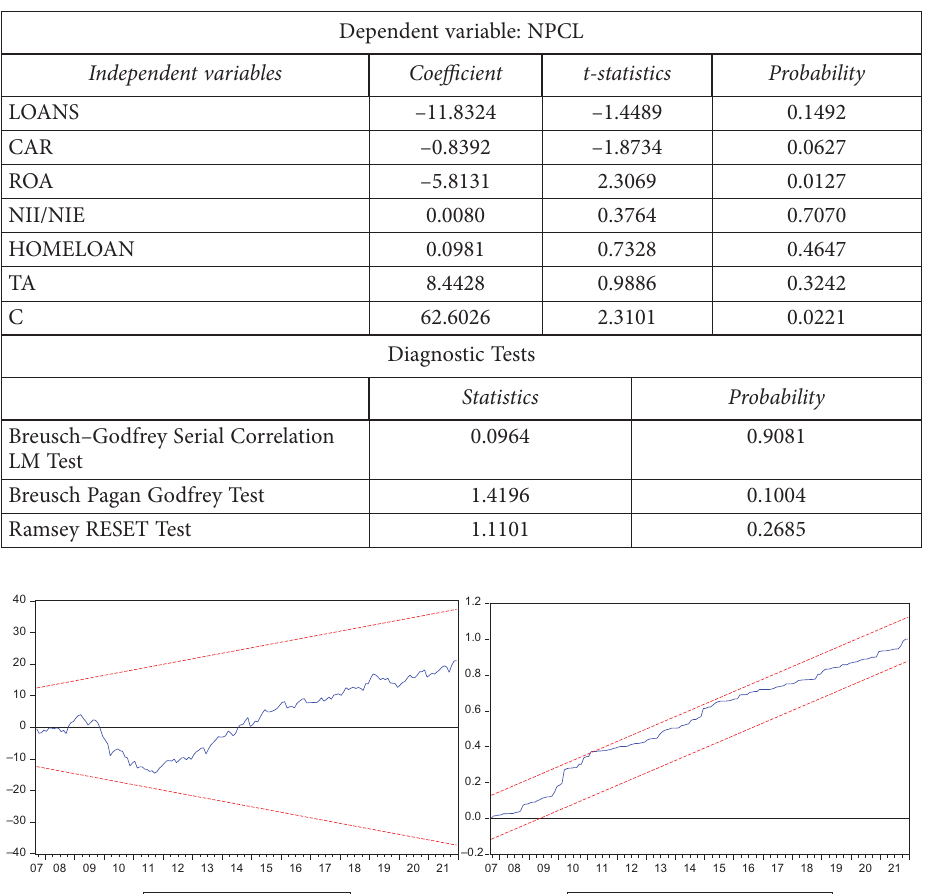
Table 8. Long-run coefficients estimation results (source: own calculation of author)